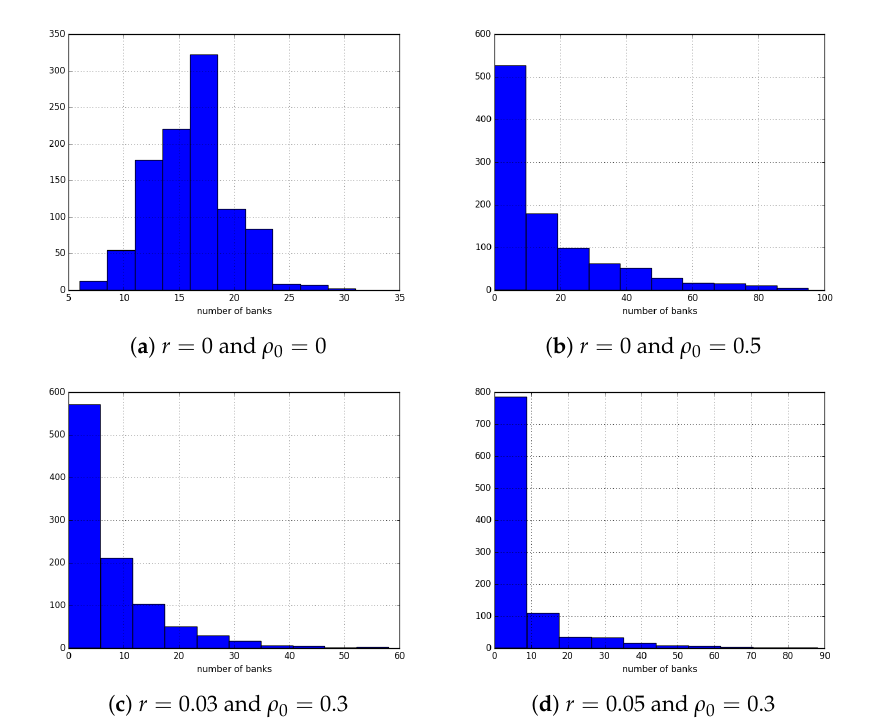
Figure 6. Histogram of the number of banks defaulting. We use the following parameters: N = 100 banks, 1000 simulations, µ i = σ i = 0.1 for i = 1, . . . , N , and no interbank flows: c ij = 0 for i , j = 1, . . . , N